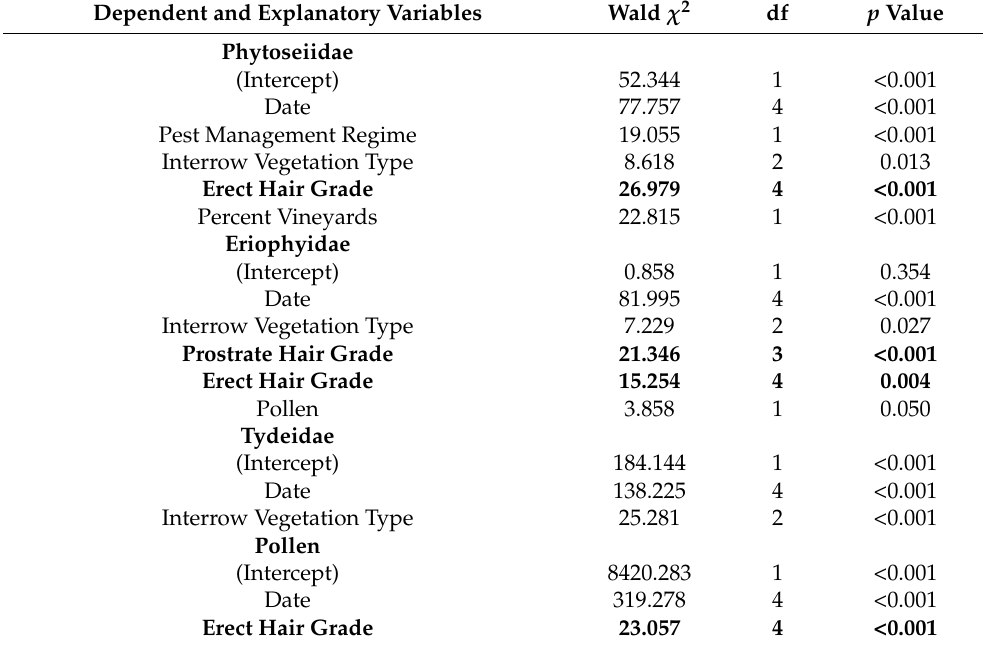
Table 1. Results of generalized linear models (GLM; normal distribution, identity link) on phyto- seiid, tydeid and eriophyid mite abundance per 100 cm² leaf area and pollen deposition per 1 cm² leaf area in vineyards sampled by Möth et al. (2021). All dependent variables were lg(x + 1) trans- formed before analysis. AICC = − 58.118, BIC = − 17.962 for Phytoseiidae; AICC = − 215.227, BIC = − 169.828 for Eriophyidae; AICC = − 90.554, BIC = − 66.906 for Tydeidae; AICC = − 22.144, BIC = 7.132 for pollen. Significant explanatory variables of leaf hairiness are highlighted in bold.